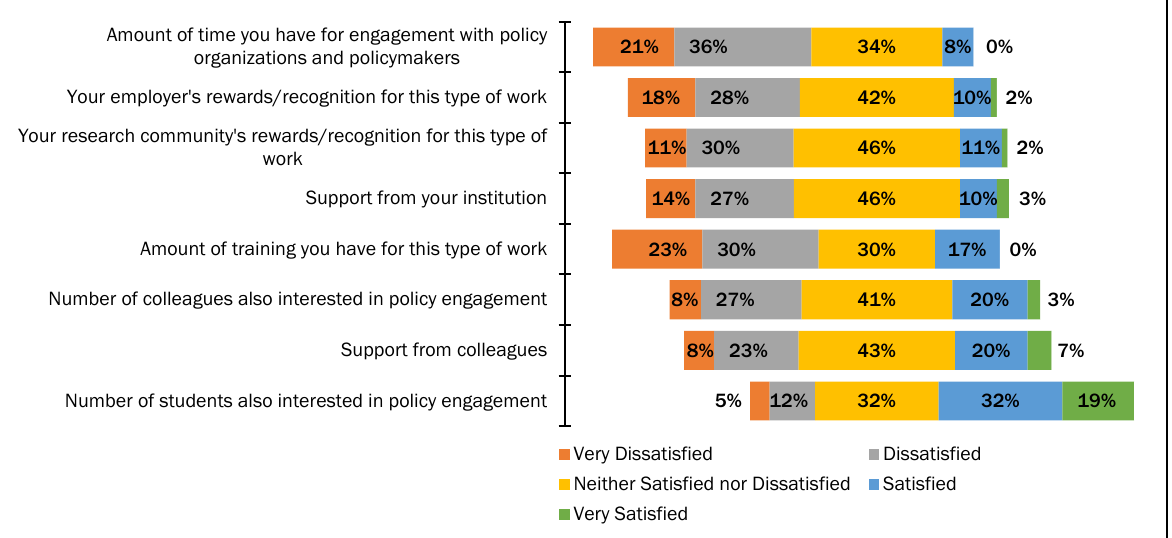
Figure 4. Satisfaction with Policy Engagement on the Topic of Sustainable Agriculture ( N